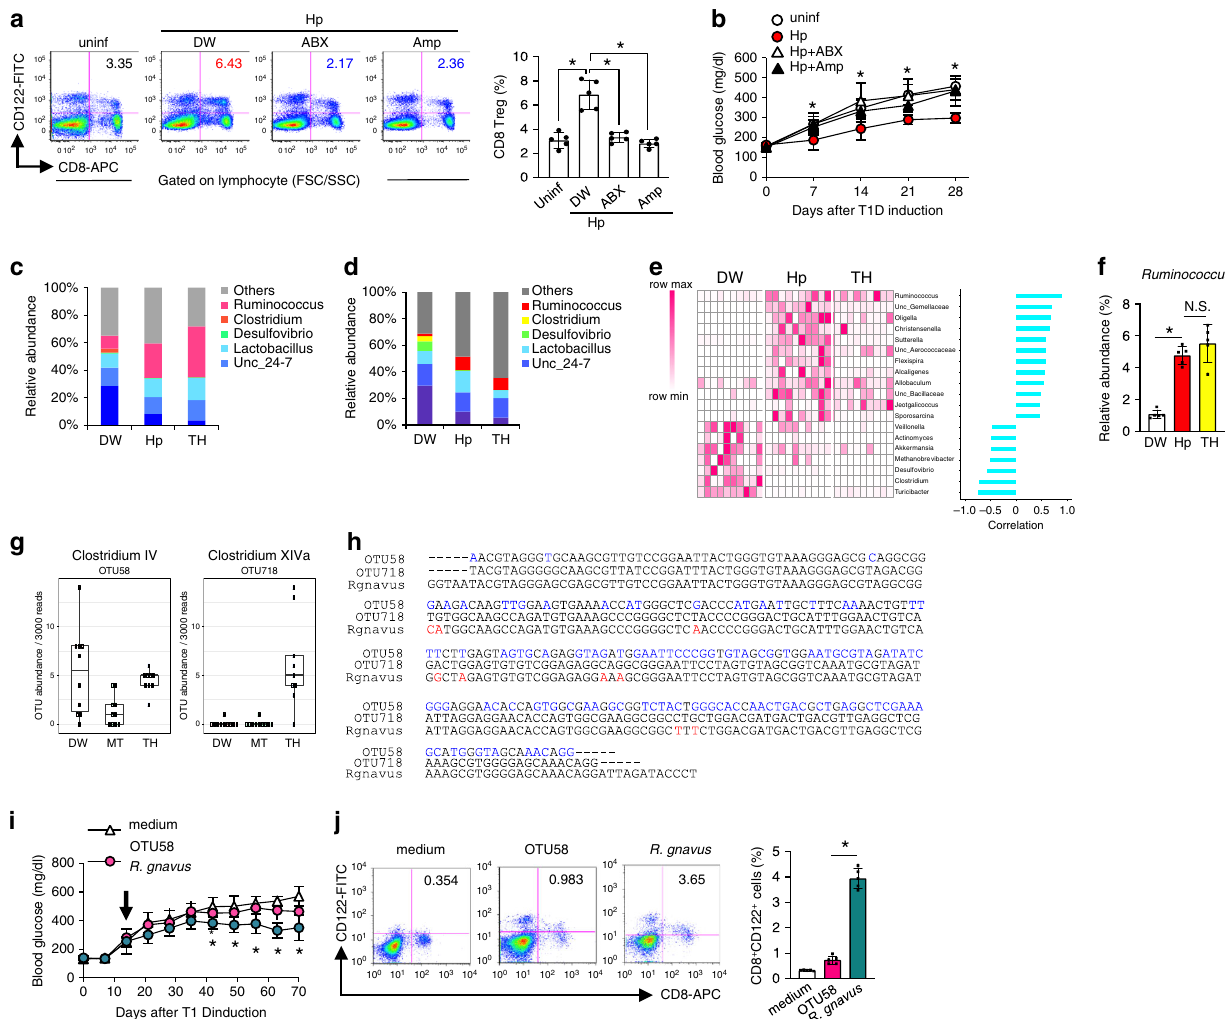
Fig. 3 Microbiota induces of CD8 + Treg cells during Hp infection. a , b Hp-infected mice treated with an antibiotic mixture (ABX), ampicillin (Amp), or untreated (DW) were used for T1D induction. CD8 + Treg cells ( a ), and blood glucose ( b ) were analysed as in Fig. 1d and a, respectively. Values represent the mean ± SD of fi ve mice. The microbiota composition at genus levels of the small intestines ( c ) and faeces ( d ) of indicated mice at 14 days after infection or feeding. Values represent the mean of 10 (DW, Hp) or 9 (TH) mice. e Heatmap showing the abundance of genera of faecal bacteria correlated with the frequency of CD8 + Treg cells in mice used in d as depicted in the colour scale ( left panel ). Each column represents an individual animal. The positive correlation is strongest from the top ( Ruminococcus ) to the 12th row ( Sporosarcina ), and the negative correlation is strongest from the bottom ( Turicibacter ) up to the 13th row ( Veillonella ) ( right panel ). f Frequency of Ruminococcus among whole intestinal bacteria in the indicated mice re-evaluated by quantitative PCR. g Abundance of OTU (operational taxonomy unit) 58 and OTU718 in mice fed with TH were measured. Values represent the mean ± SD of fi ve mice. h Partial DNA sequences of 18S rRNA of Ruminococcus gnavus , OTU58, and OTU718. Eight different nucleotides out of 257 between R. gnavus and OTU718 are depicted in red, and those between OTU58 and OTU718 (119/254) are depicted in blue. i Glucose levels were monitored in STZ- treated mice orally inoculated with OTU58 or R. gnavus . Values represent the mean ± SD of fi ve mice. j Frequencies of CD8 + Treg cells among spleen cells cultured in the presence of culture supernatant from OTU58 or R. gnavus for 48 h were analysed by fl ow cytometry. Numbers in pseudocolor plots indicate the percentages of CD8 + Treg cells summarised as a bar graph. Values represent the mean ± SD of fi ve mice. Asterisks denote statistical signi fi cance at p < 0.05 calculated by Tukey post-hoc analysis ( a , f , j ), two-way ANOVA ( b , i ). All experiments were repeated at least three times with similar results. Immunohistochemical examinations . Pancreatic tissues excised from mice after Heligmosomoides polygyrus infection . Hp were maintained in mice and serially STZ administration were fi xed in 4% paraformaldehyde and embedded in paraf fi n. passaged. For experimental infections, we used infectious L3 larvae obtained from Tissue sections (5- μ m thick) were subjected to immunohistochemistry with a eggs in the faeces of infected mice after culture on fi lter paper soaked in distilled polyclonal guinea pig anti-insulin antibody (A0564, Dako) at 1:200 dilution. water 34 . Mice were orally infected with 200 L3 larvae in 500 μ l DW by gastric Stained areas were quanti fi ed using a BZ-8100 microscope (Keyence), NIS- intubation. Establishment of infection was con fi rmed by detecting eggs in faeces. Elements (Nikon), and ImageJ (NIH) 35 . At least 10 sections from individual mice were examined. Induction and evaluation of diabetes . C57BL/6J mice were intraperitoneally administered STZ (50 mg/kg body weight) for fi ve consecutive days to induce Flow cytometry . Single-cell suspensions of mouse spleens, mesenteric lymph diabetes, as described previously 12 . Blood samples were periodically collected from nodes, pancreatic lymph nodes, and pancreatic tissues were incubated with an anti- mice via puncture of the tail vein to monitor blood glucose concentrations using CD16/32 (93; eBioscience) to block Fc receptors to prevent non-speci fi c antibody lab glucose cartridge and sensor devices (ForaCare Inc.). The determination of binding and then stained with the following mAbs conjugated to fl uorescein iso- insulin levels in serum samples was performed by an LBIS mouse Insulin ELISA kit thiocyanate (FITC), phycoerythrin (PE), allophycocyanin (APC), phycoerythrin- (AKRIN-011RU, Shibayagi Co. Ltd.), according to the manufacturer ’ s instructions. NATURE COMMUNICATIONS| (2020) 11:1922